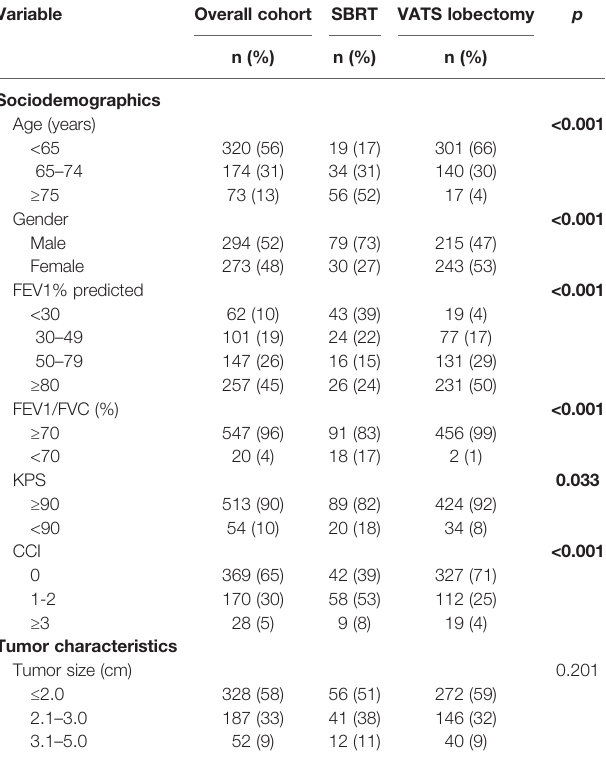
TABLE 1 | Characteristics of patients with early-stage NSCLC strati fi ed according to treatment. Variable Overall cohort SBRT VATS lobectomy